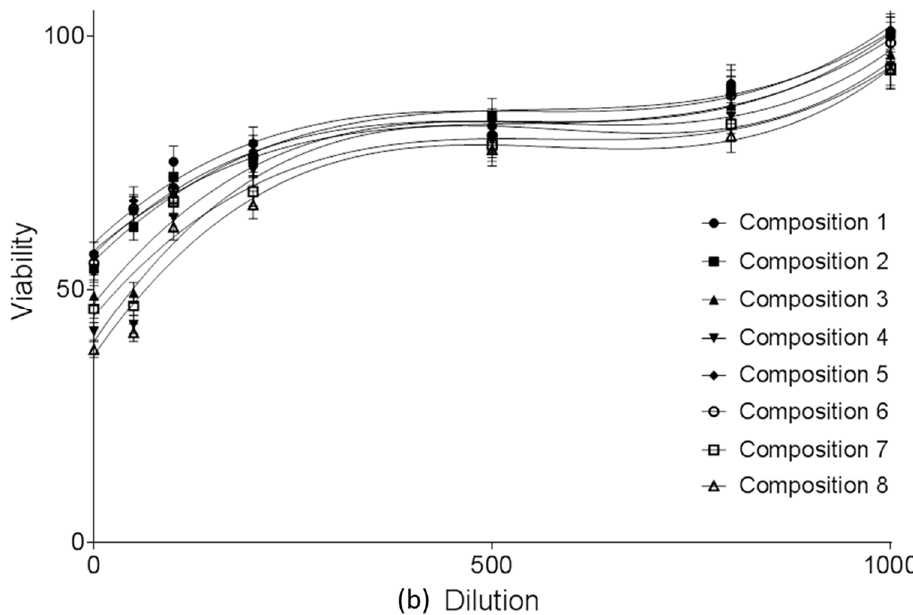
Figure 3. ( a ) Cell viability evaluation following MTT assay on Caco-2 cells treated with compositions 1 – 8 in the function of dilution ratio. 1 mg PL-SNEDDS composition was diluted by 1–1000 mL HBSS. Each data point represents the mean ± S.D., n = 10. Significant differences between groups for compositions 1 , 2 , 5 , 6 and groups for compositions 3 , 4 , 7 , 8 are marked with an asterisk (with the exception of composition 3 vs. compositions 5 and 6 at 100 dilution ratio, where the differences did not reach level of statistical significance). Positive control was Triton-X-treated group, negative control was Hank’s balanced solution (HBSS)-treated group; ( b ) Linear regression of cell viability curves presented in the Figure 3a (regression parameters and goodness of fit data shown in Table